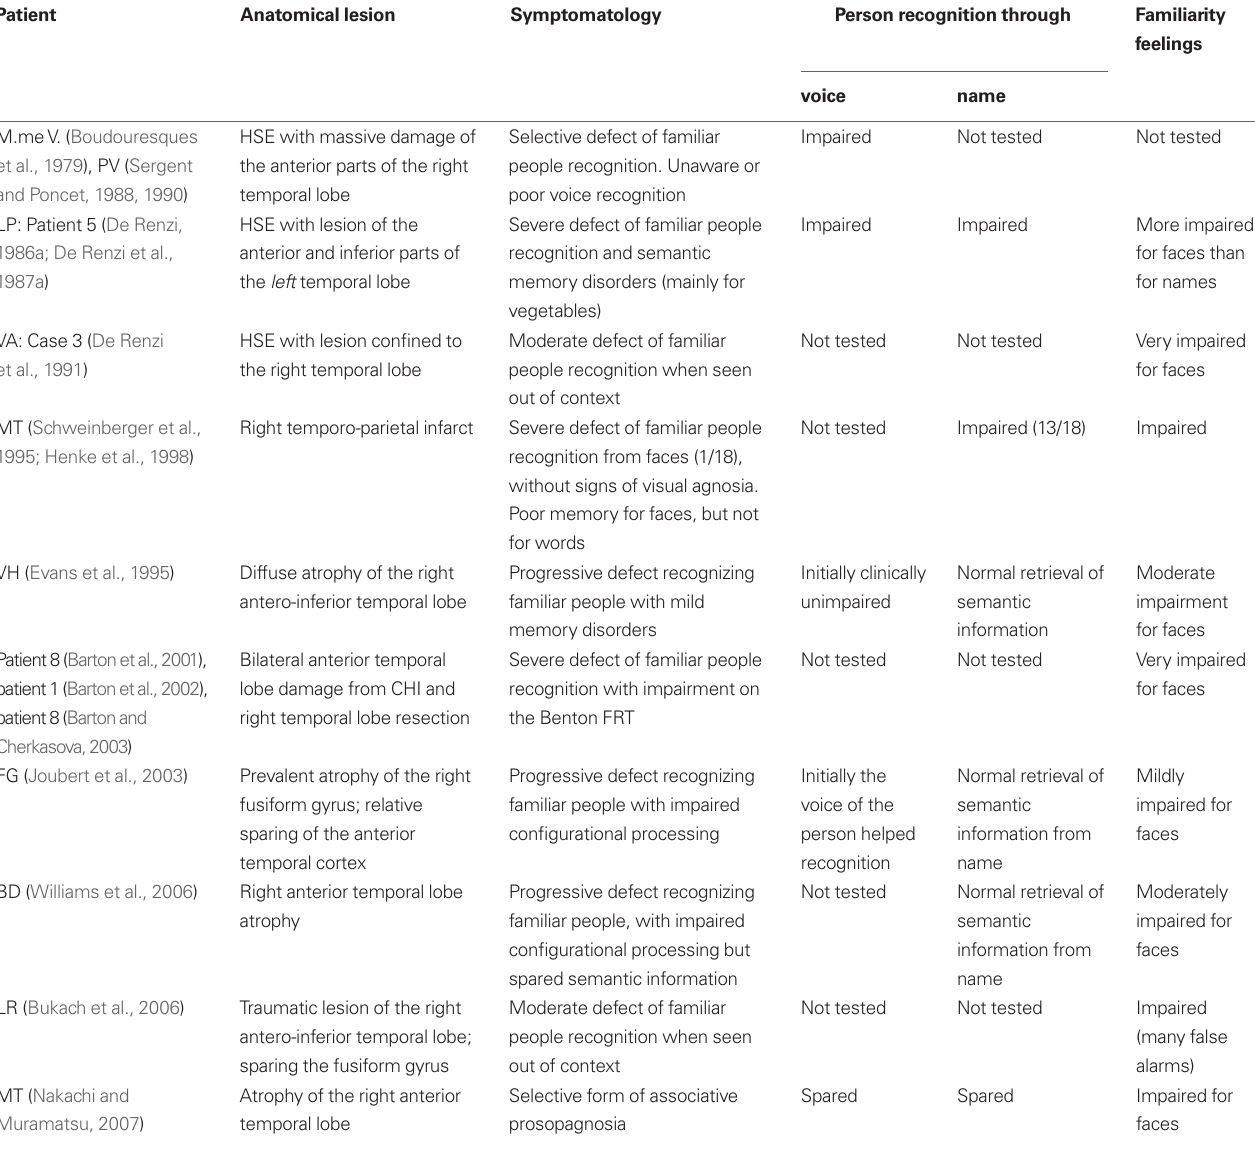
Table 4 | Patients we found in the literature with face recognition disorders labeled as “prosopagnosia” and associated with anterior temporal lesions. Patient Anatomical